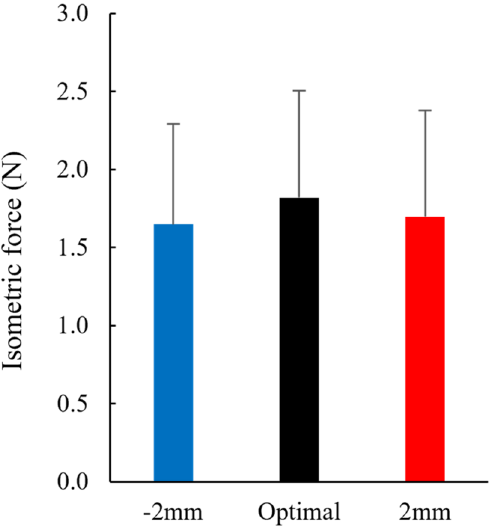
Figure 4. Comparison of the isometric force among − 2 mm, optimal, and 2 mm conditions (N = 9) (means ±